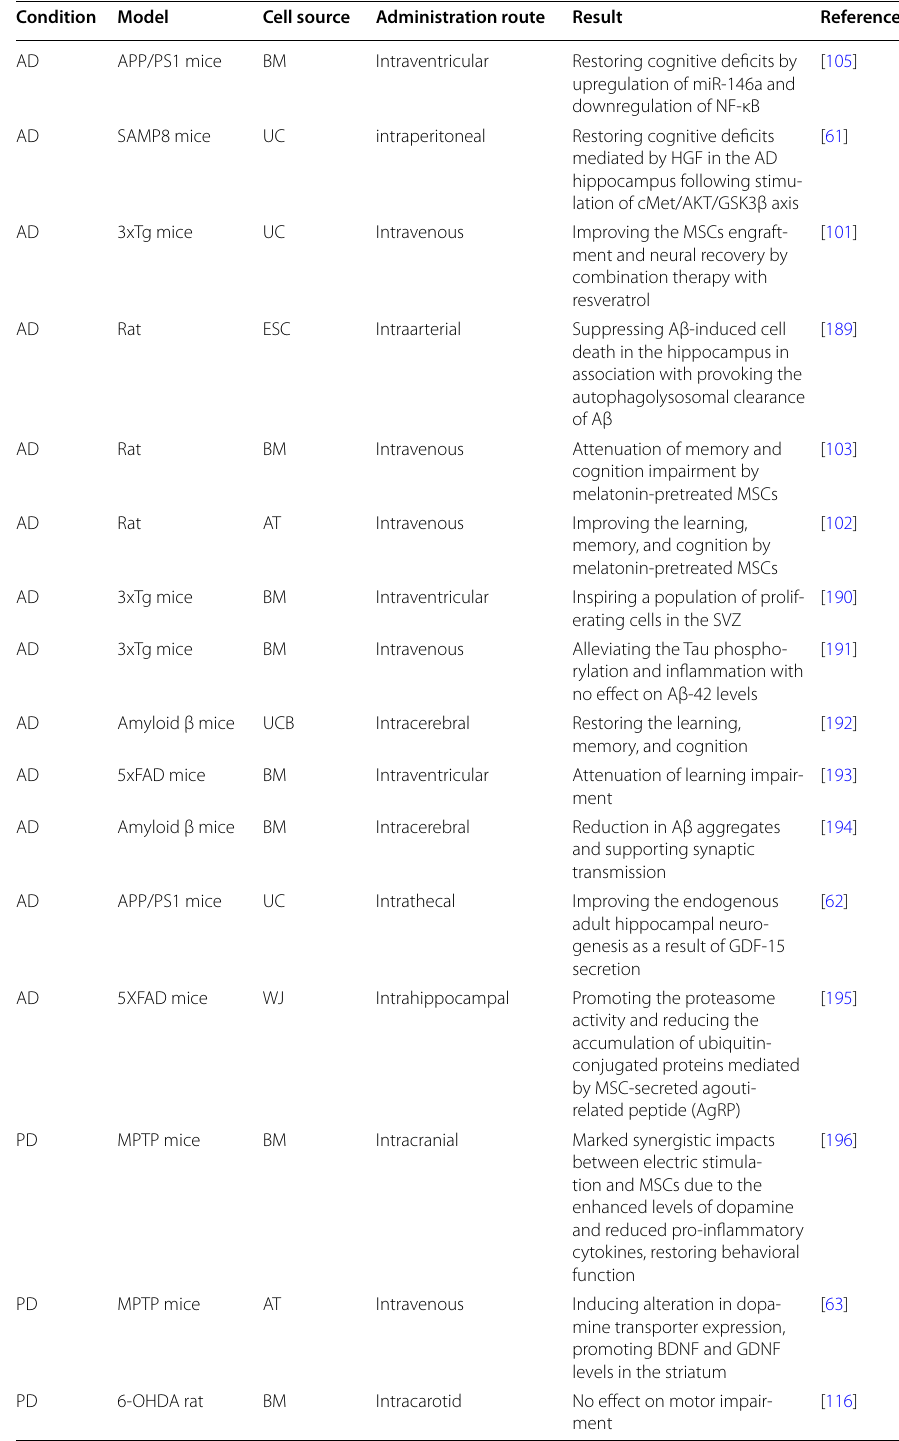
Table 1 Native MSC therapy in preclinical models of common neurodegenerative